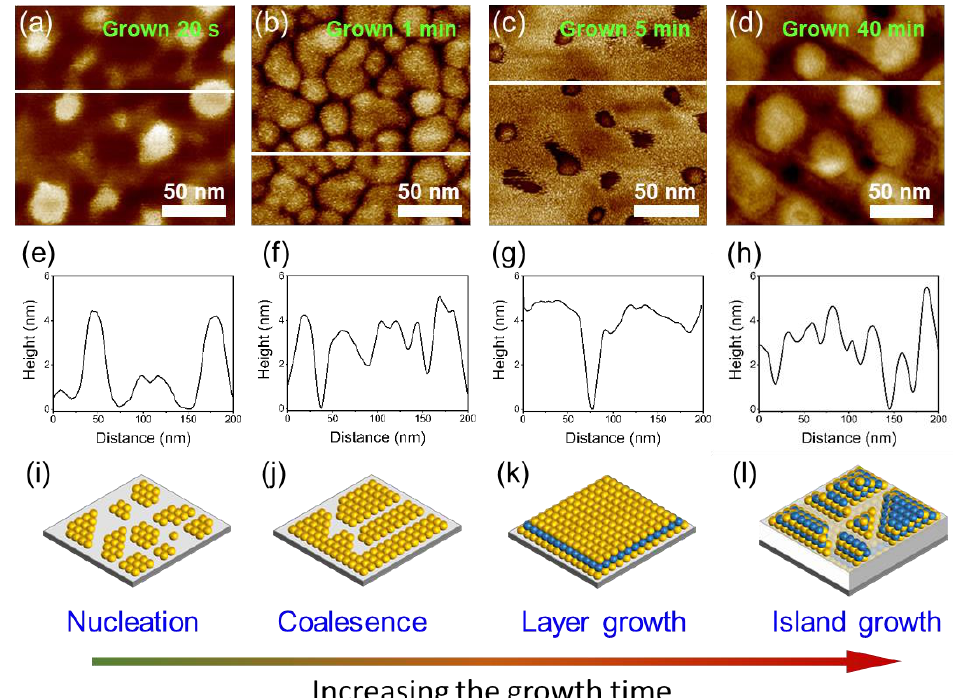
Figure 2. Surface morphologies and the film growth mode for Mg 3 Sb 2 films grown on Al 2 O 3 substrates. ( a – d ) AFM images at different stages of the film growth for the films grown at T sub = 773 K; ( e – h ) The corresponding height profiles along the white lines in ( a – d ); ( i – l ) The schematic illustration of the film growth mode that fits the characteristic of the Stranski–Krastanov (SK) mode.